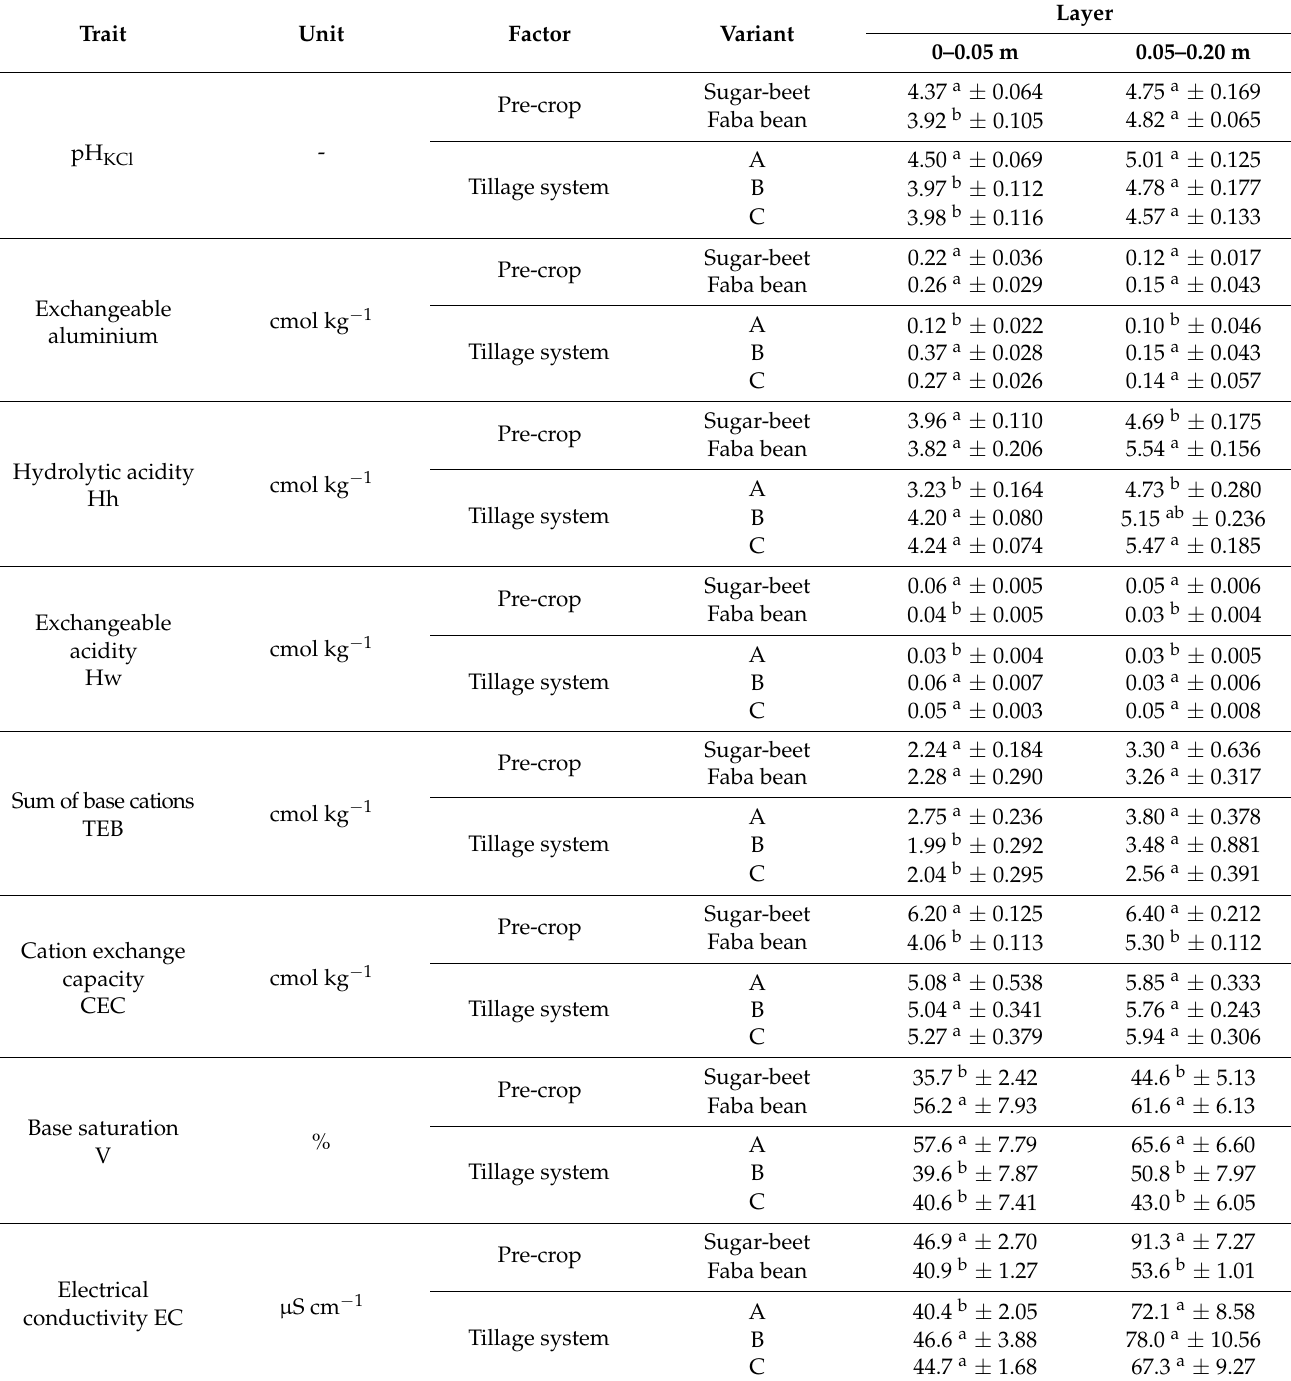
(Table 2). According to the adopted norm [17], the soil in the experiment is to be considered acidic and very acidic. Table 2. Physicochemical elements of soil depending on pre-crop and tillage